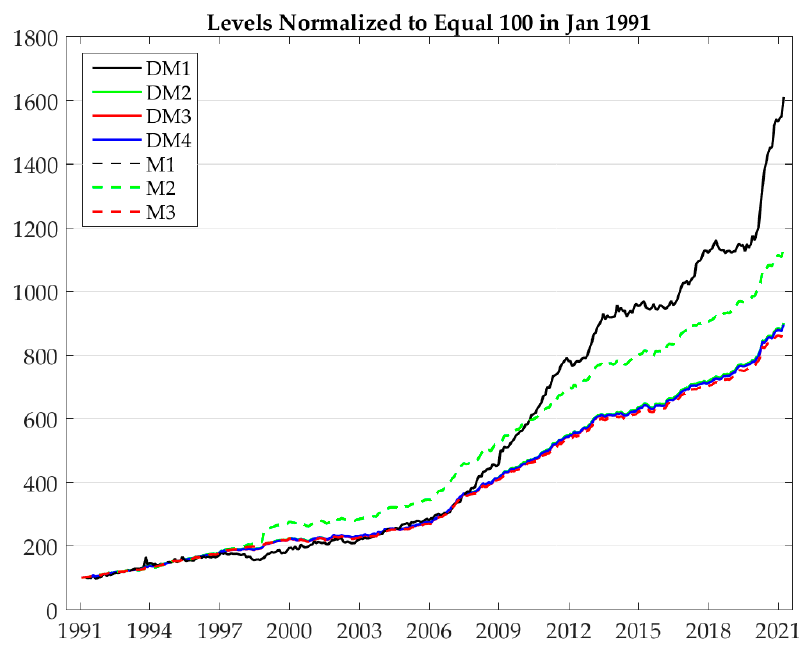
Figure 2. Divisia versus simple sum aggregates, 1991–2021.